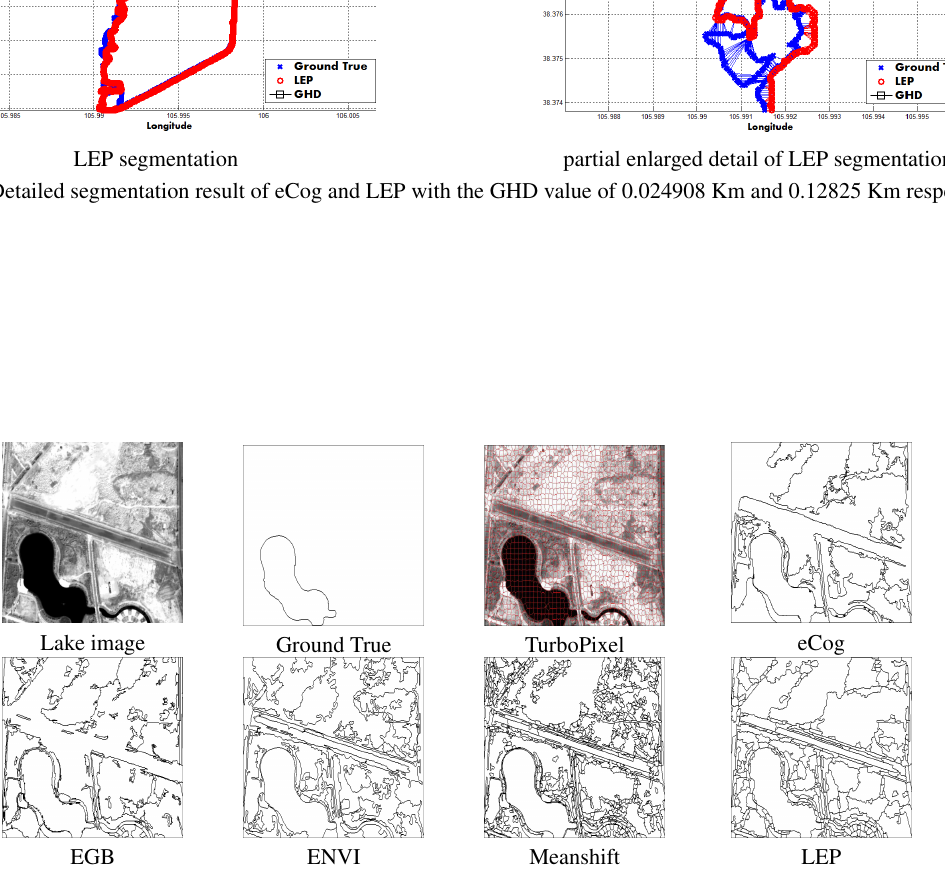
Figure 4: Lake segmentation results, with the GHD values shown in Table